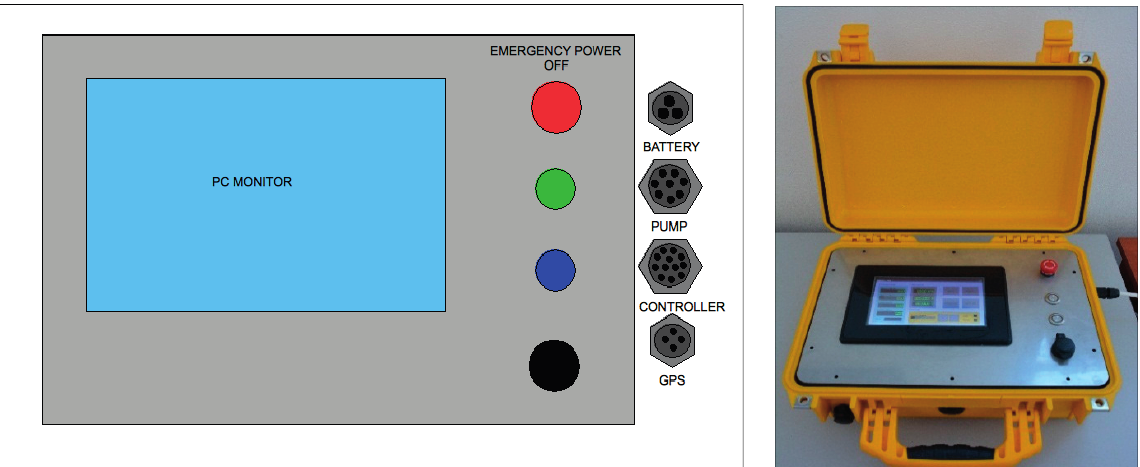
Figure 12. The electronic unit: the scheme ( Left ) and the realized prototype ( Right